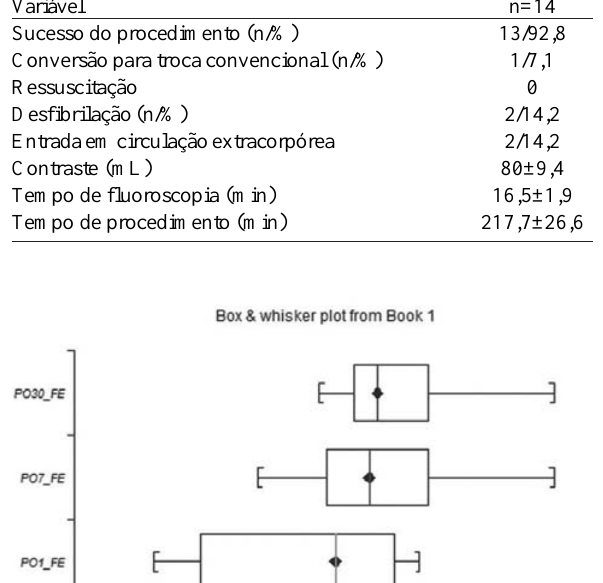
Nenhum paciente apresentou bloqueio atrioventricular total ou necessidade de implante de marcapasso